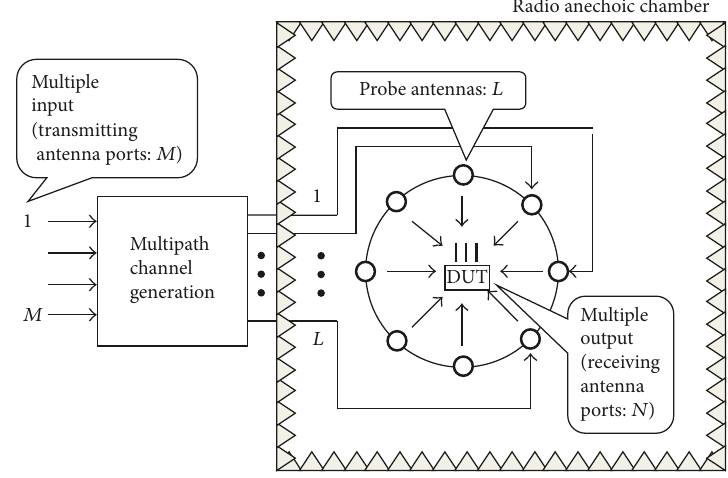
Figure 2: General configuration of an FE MIMO-OTA system.